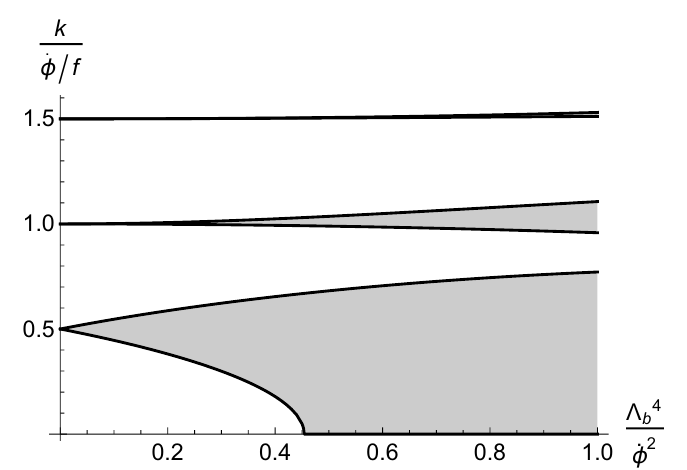
Figure 2 . In grey, the instability bands of eq. (2.11). Inside those bands, the solution grows exponentially. For the calculation of the boundaries of the instability bands, see e.g., ref.